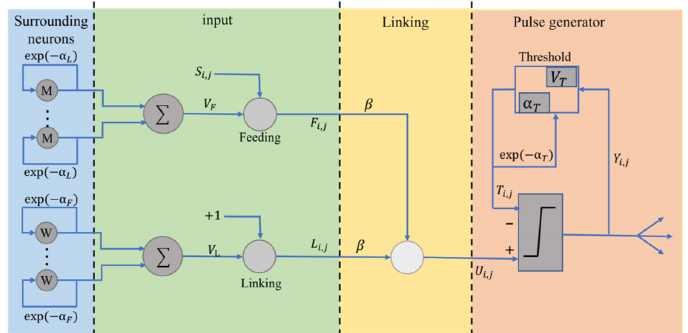
Figure 1. Working principle diagram of the PCNN.